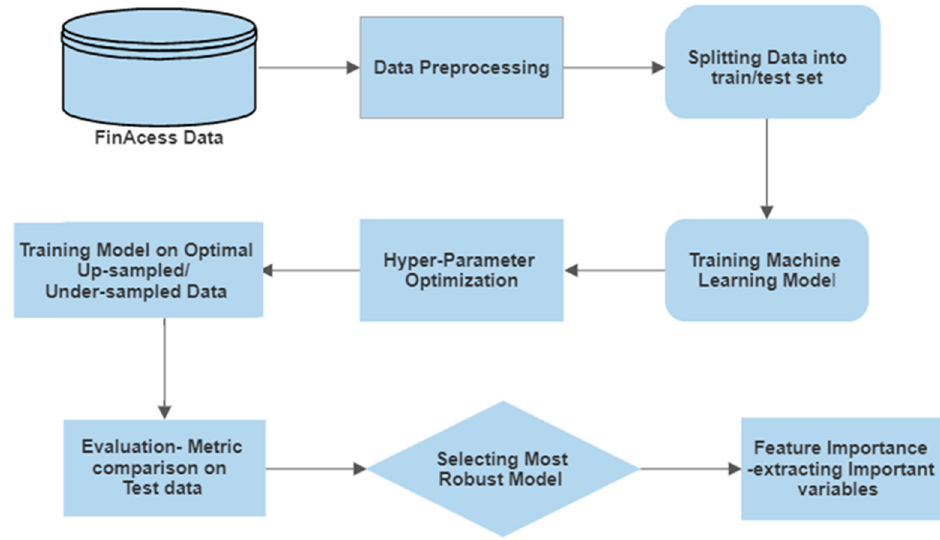
Figure 1. General machine learning process